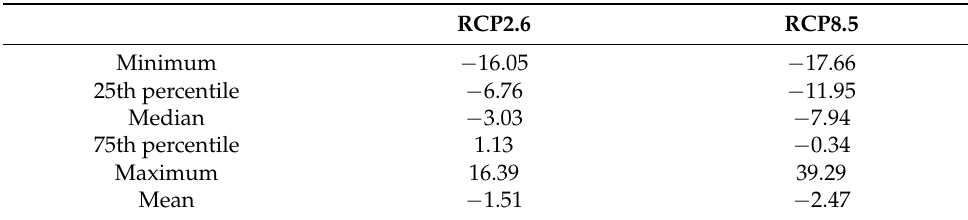
Table 1. The annual impacts of climate change on soybean yield in Brazil (average over 2020–2039) in